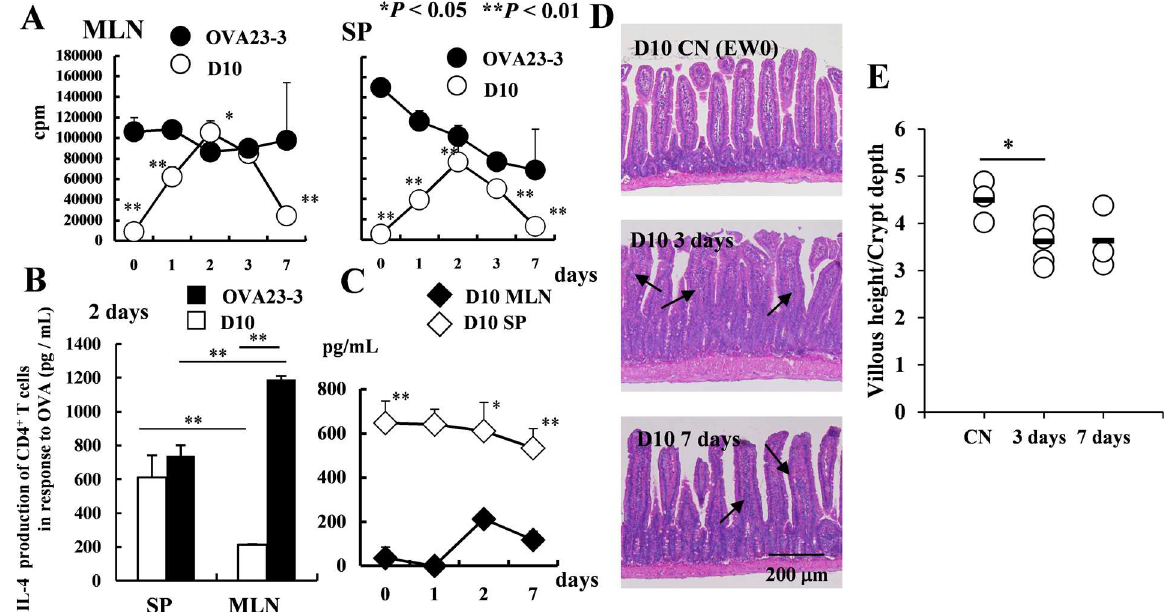
Fig 4. CD4 + T-cell function after shorter period of EW feeding in D10 and OVA23-3 mice. A , Proliferative responseson days 0 through 7 and B , IL-4 levels on day 2 of CD4 + T cells purifiedfrom MLNs or spleen(SP) of EW-fed OVA23-3 (n = 3) and D10 mice (n = 3). C , IL-4 production by CD4 + T cells from spleen (SP) and MLNs of EW-fed D10 mice on days 0 through 7. D , Jejual sections obtainedfrom D10 mice fed with EW diet for 0 days (top panel;D10 CN[EW0]), 3 days (middle panel; D10 3 days), and 7 days (bottom panel; D10 7 days). Arrows indicateregions of cellularinfiltrationinto the lamina propriaof each villus in sections from EW-fed D10 mice. The top panel indicatesthe normal jejunumof CN-fed D10 mice; the jejunalsections from EW-fed D10 mice on day 3 (middle panel)and day 7 (bottom panel)show slight significantelongationof crypts (described in E ) comparedwith normal section (top panel). E, Ratio of villousheight to crypt depth of the jejunum. The ratio was significantly decreased (that is, crypt elongation; * P < 0.05) in EW-fed group (3 days) comparedwith control groups. The results shown are representative of the 2 replicates. Supernatants were collectedat 48 hours after stimulationfor OVA23-3 mice or after 72 hours for D10